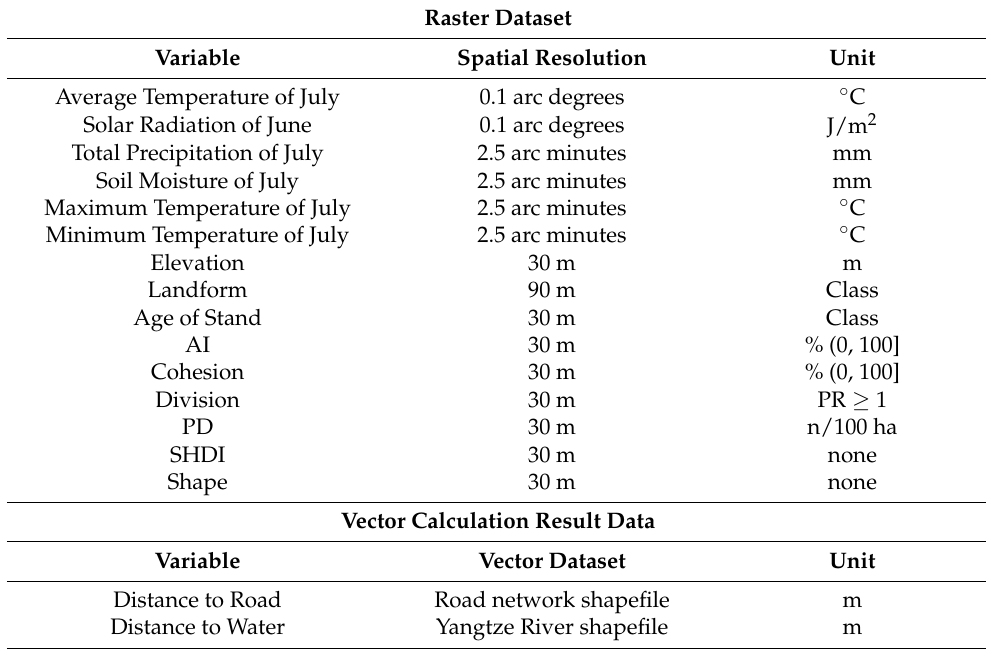
Table 1. Influence factors used to predict the distribution of pine wilt diseasein Yichang